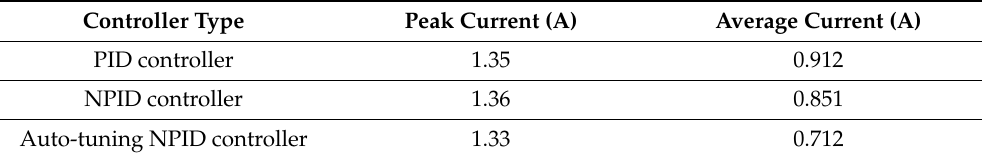
Figure 10. Acceleration of sprung mass. Figure 10. The corresponding instantons current in amperes (A) for the UDDS test. Table 4. Uncertainty parameters of the EV system. Table 4. The current consumption for each control